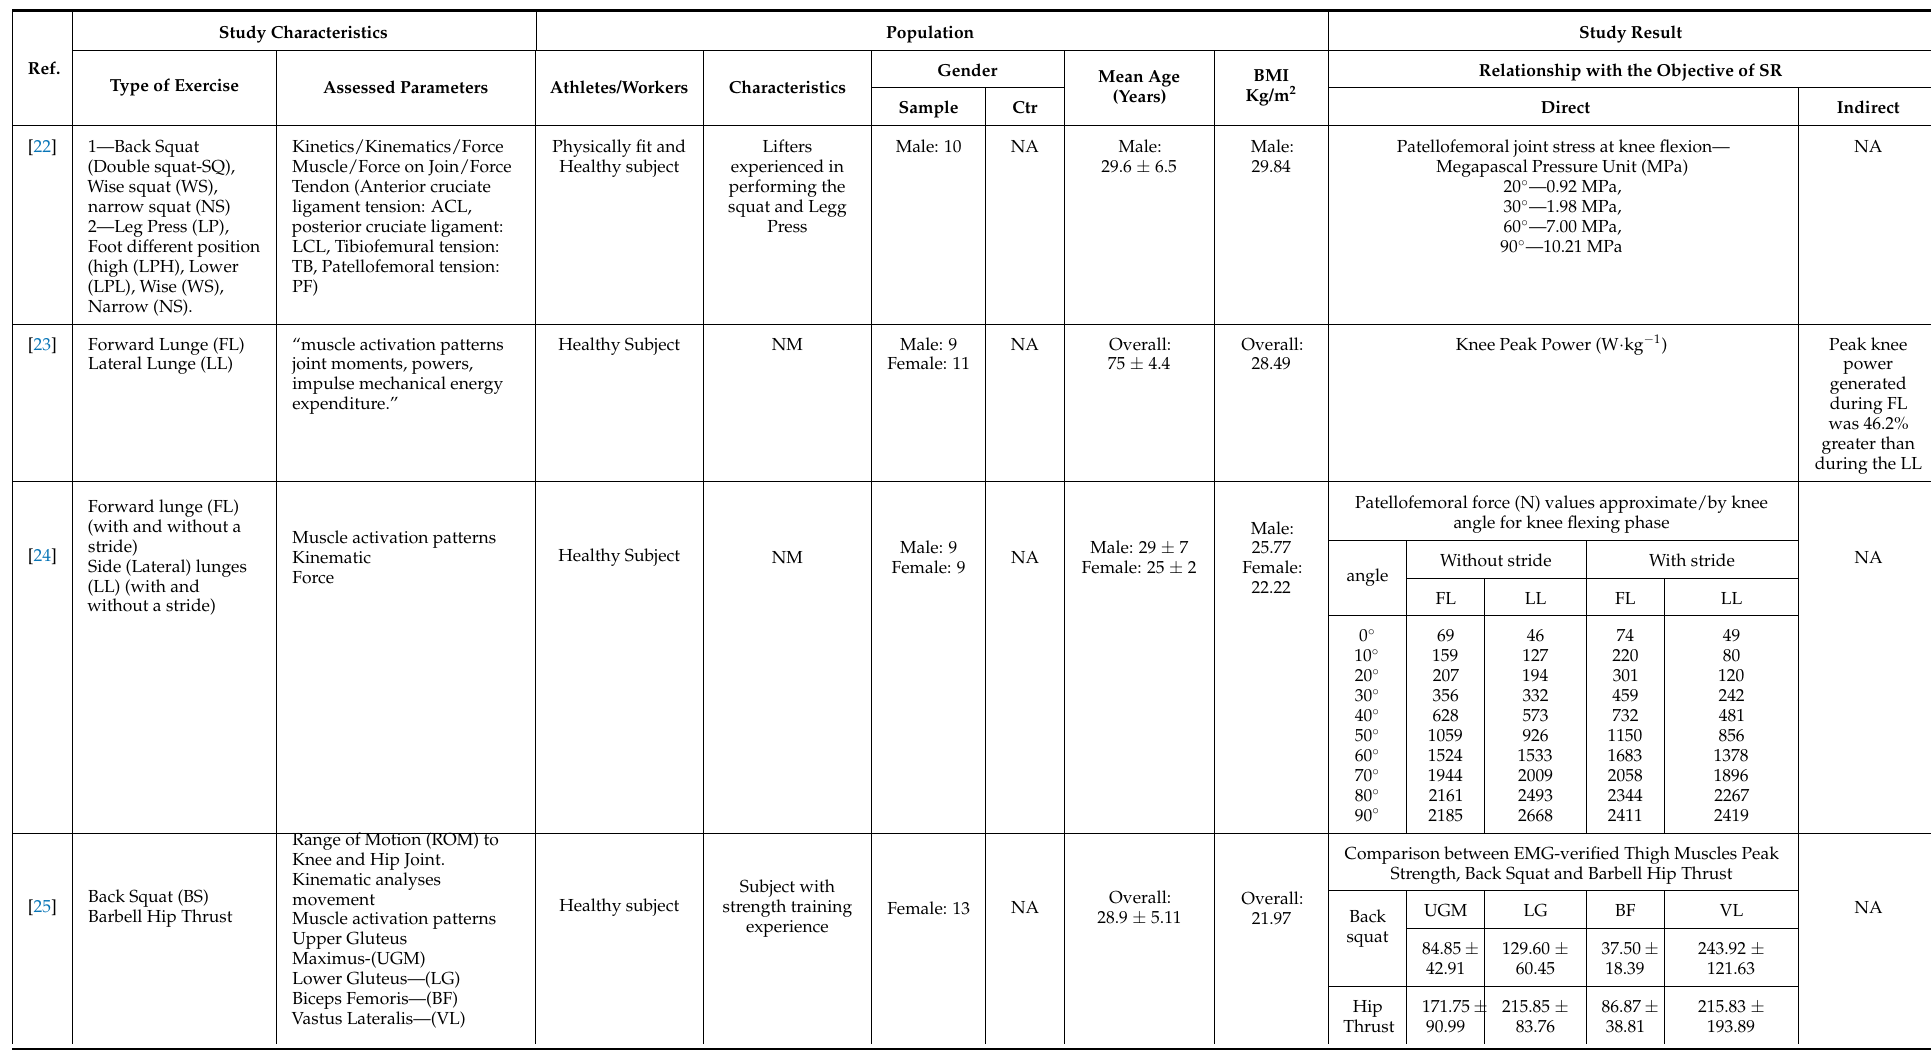
Table A1. Studies